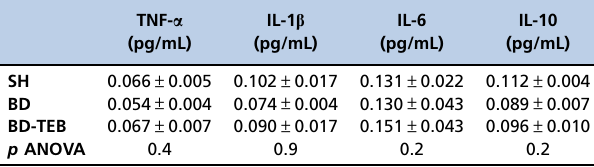
SH: sham-operated rats; BD: brain-dead non-treated rats; BD-TEB: brain- dead rats under thoracic epidural blockade. These measurements were performed 180 min after the surgical procedures. The data are presented as the means ±